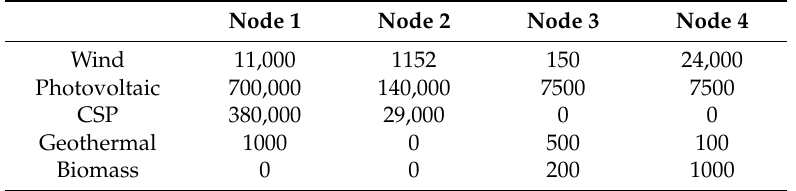
Table 4. Maximum capacity of renewable generation to be installed in each node